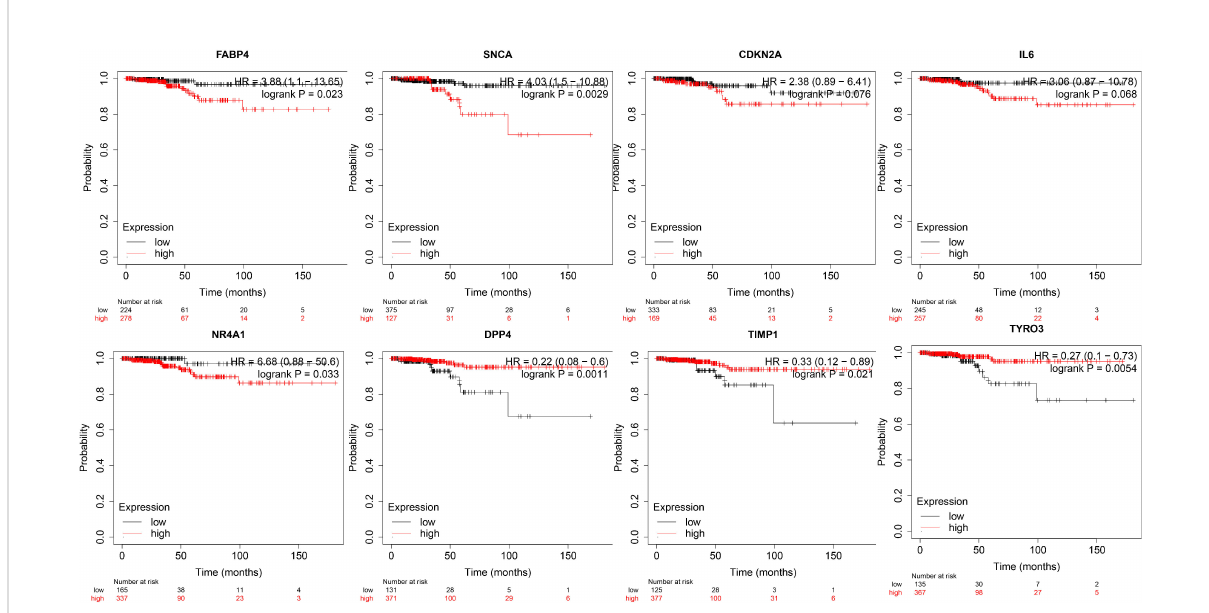
FIGURE 4 Kaplan-Meier curves of genes associated with the eight gene prognostic risk